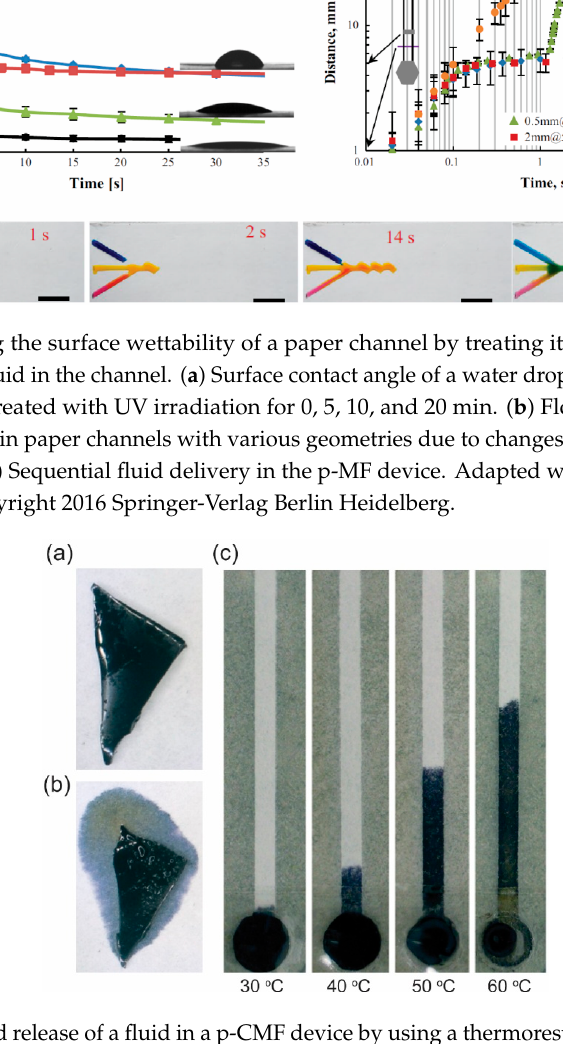
Figure 14. Controlled release of a fluid in a p-CMF device by using a thermoresponsive hydrogel. Fluid ( a ) stored in and ( b ) released from a hydrogel at high temperature. ( c ) Controlling the length of fluid flow in a p-CMF device by heating it at different temperatures. Reproduced with permission from the authors of [93]. Copyright 2015 The Royal Society of Chemistry.